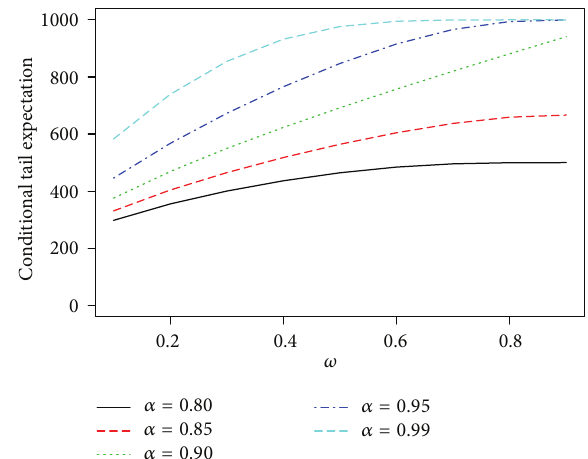
Figure6:TheapproximatedCTEsof 𝑆 1000 ,byconfidencelevel 𝛼 and the limiting correlation 𝜔 , under the 𝛽 - 𝛽 model.